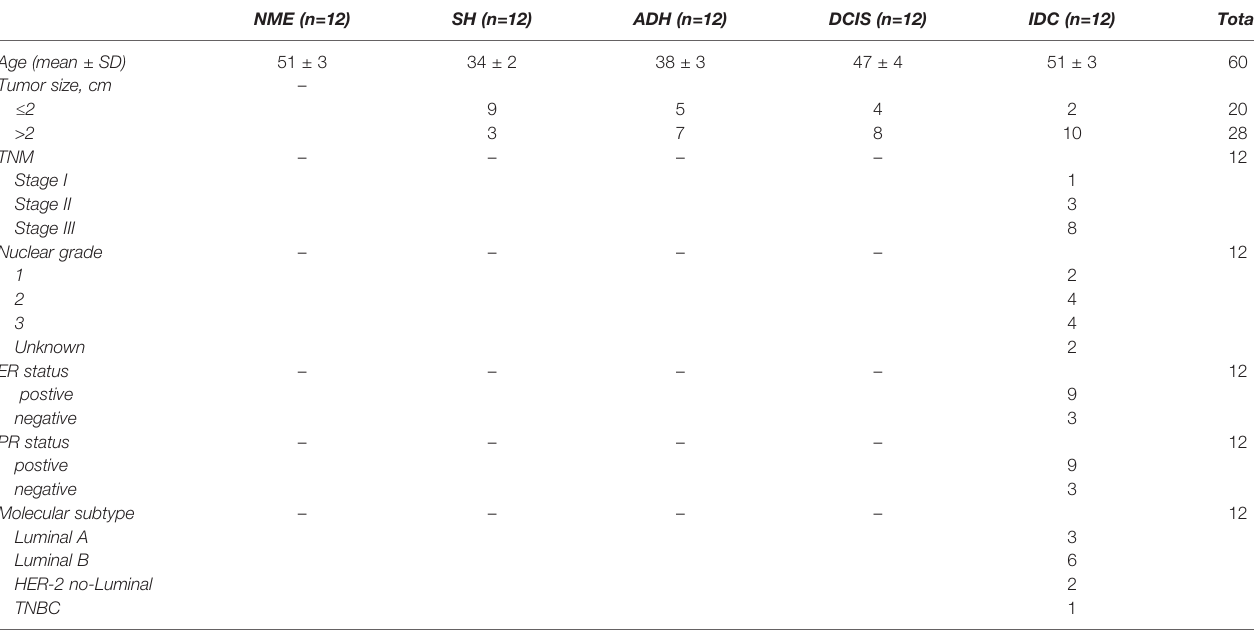
TABLE 1 | Clinical characteristics of the patients who provided tissues for the TMA